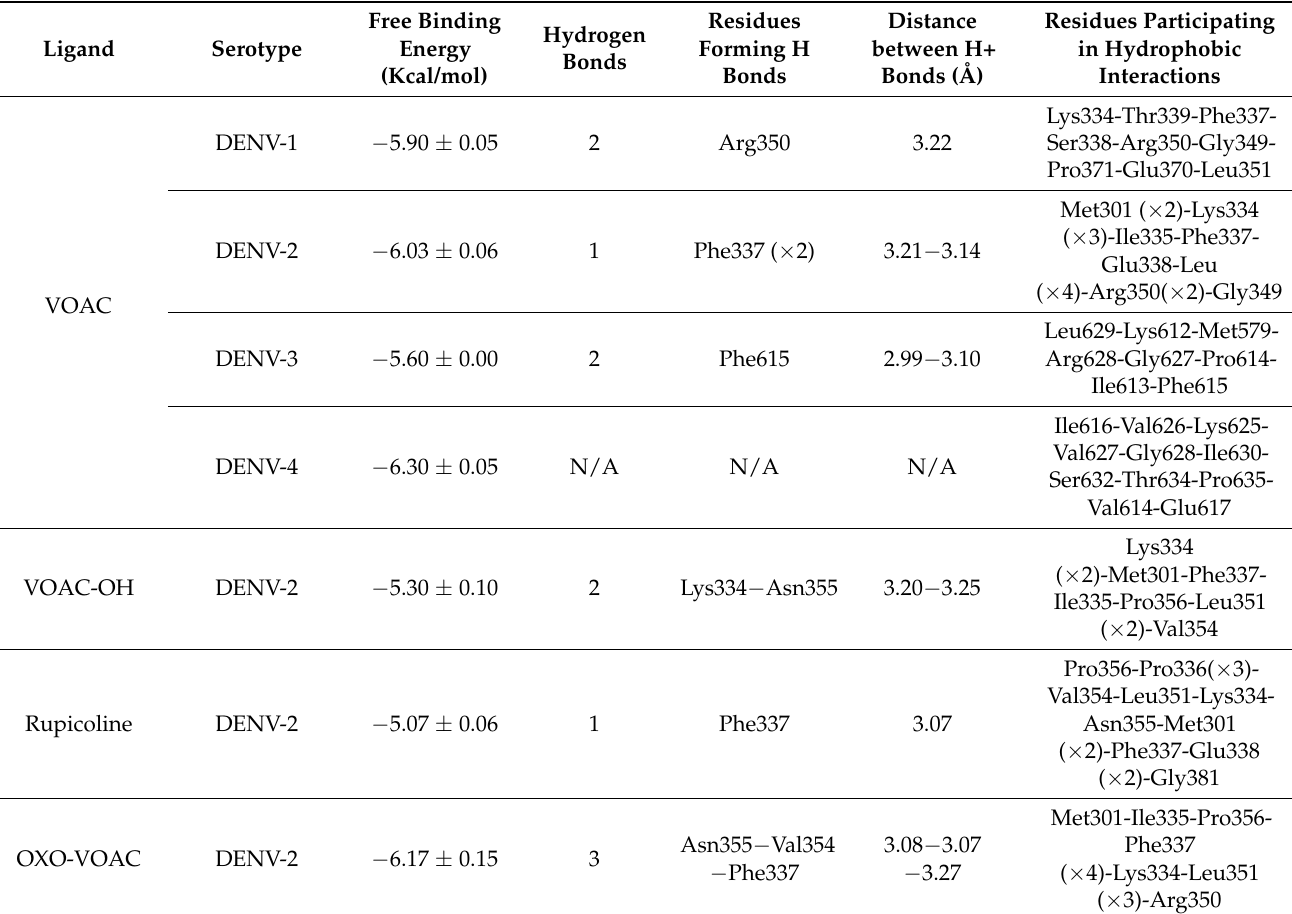
Table 2. Molecular docking and in silico interactions between DENV and each of the compounds.